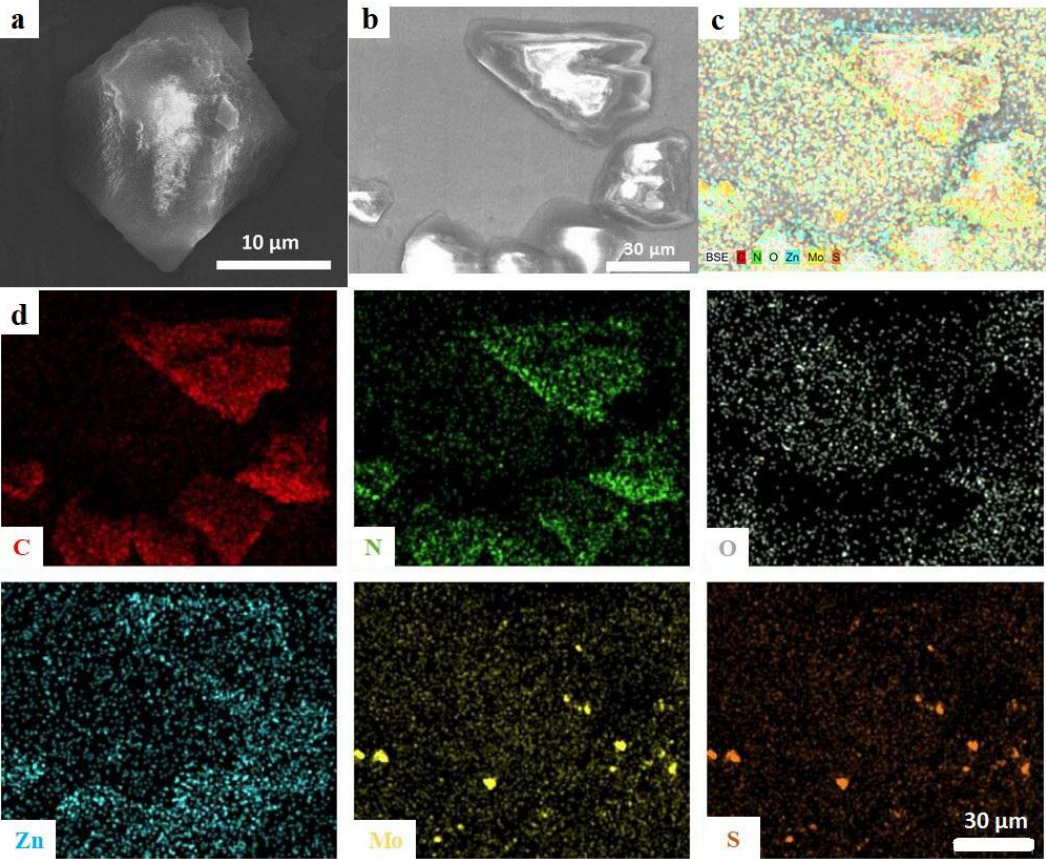
Figure 1. ( a , b ) SEM images and ( c , d ) energy dispersive X-ray spectroscopy (EDS) elemental mappings of the exfoliated MoS 2 @ZIF-8 (MZ) with a copper foil background.